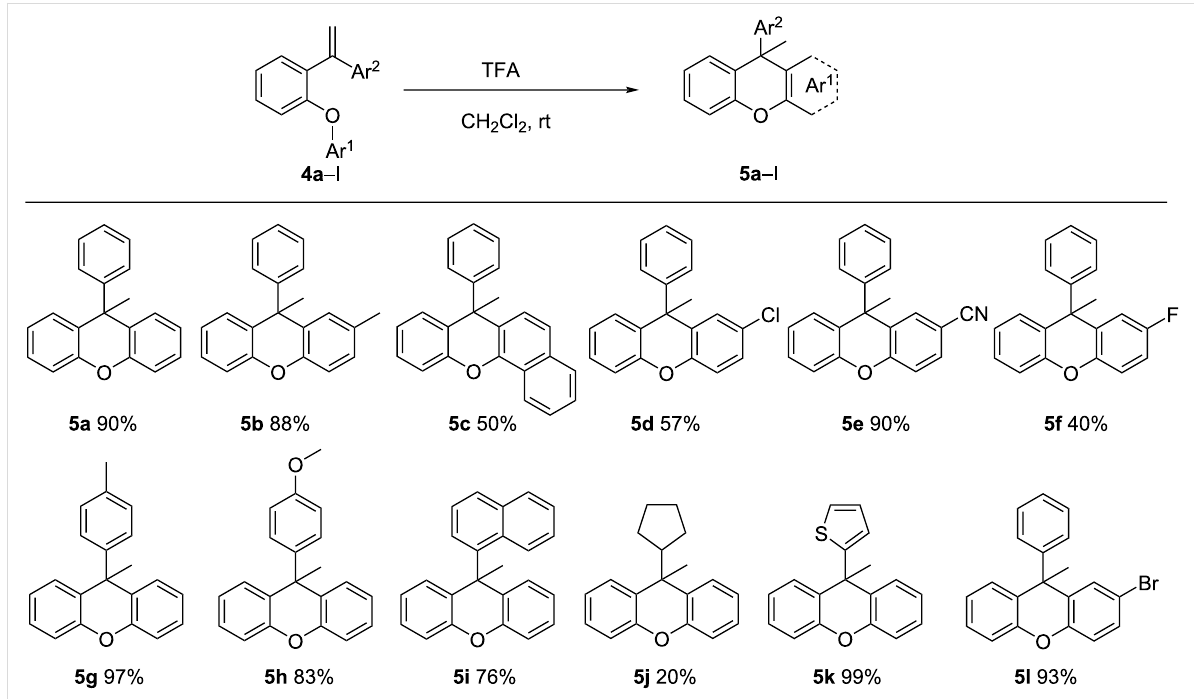
Figure 1: Scope of substrates for intramolecular FCA by activation of 4a–l and their isolated yields. a Conditions: 4a–l (0.1 mmol) and TFA (10 mol %) in dry CH 2 Cl 2 (1 mL) were stirred at room temperature for 1–24 hours. b Yield of isolated product.